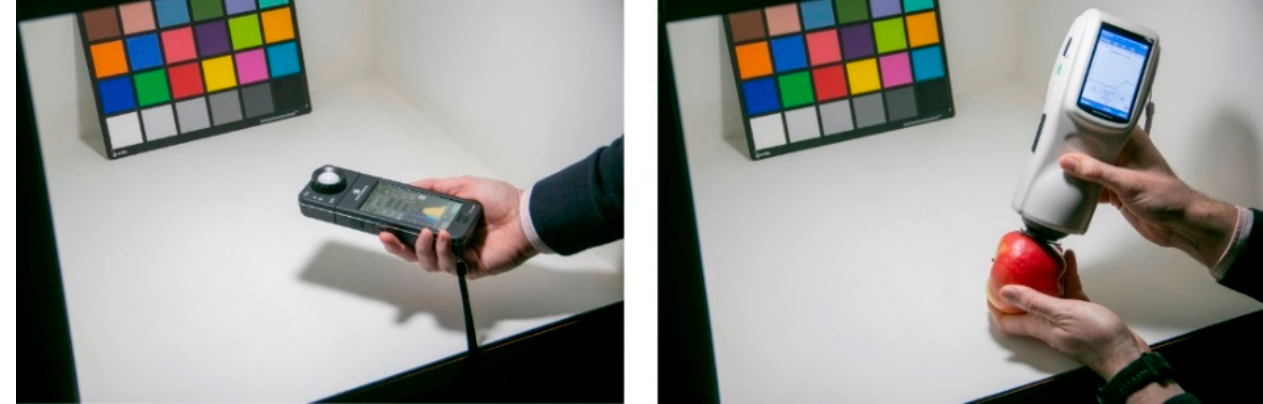
the testing box. Figure 4 represents the spectral measurements of daylight inside the testing